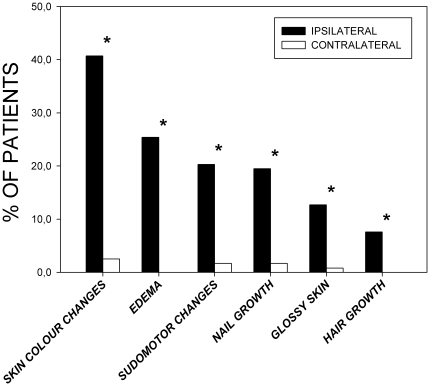
Clinical assessment of sudomotor dysfunction, throphic dysfunction, and edema.Bars represent the percentage of patients displaying the respective signs or symptoms. Significance: * p<0.05 ipsilateral hand vs. contralateral hand, Wilcoxon signed ranks method test.